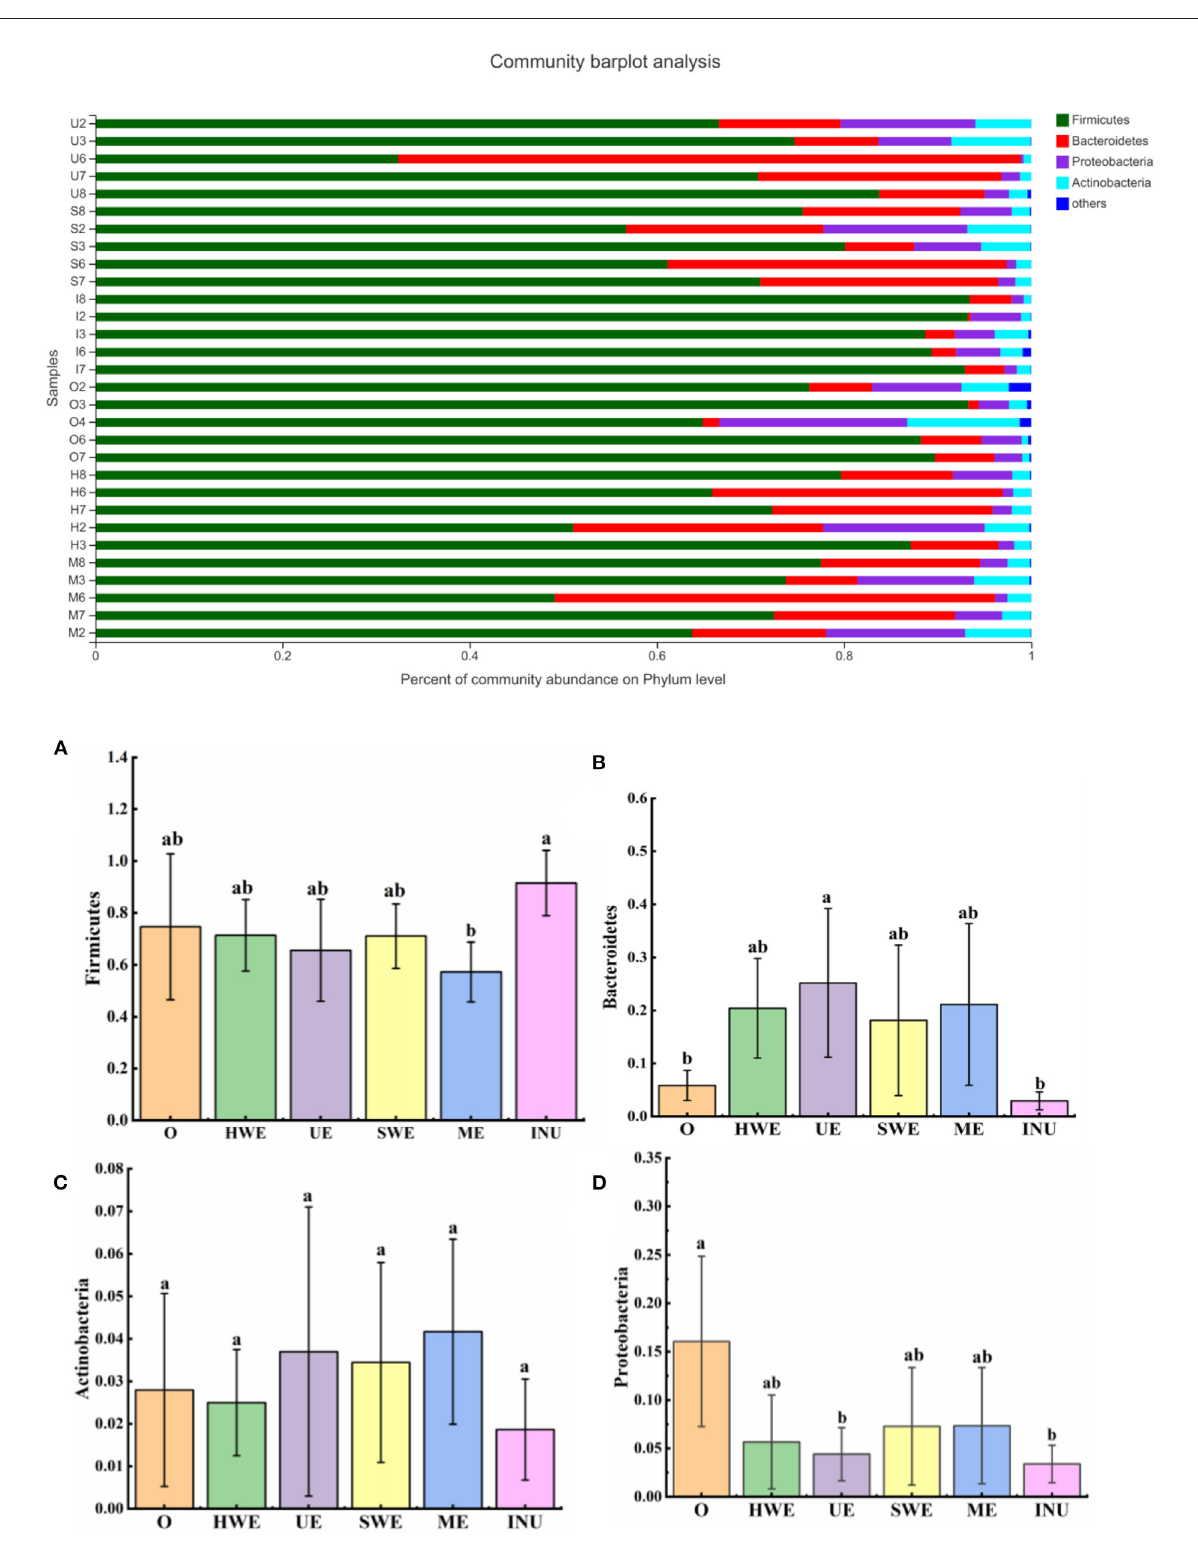
FIGURE7 (A-D) Relative abundance of gut microbiota at the phylum level ( n = 5). O stands for blank control group. HWE or H, UE or U, SWE or S, and ME or M stand for dietary fiber extracted with hot water, ultrasonic assisted, subcritical water, and microwave assisted methods, respectively. INU or I stand for inulin. Different letters a and b indicate significant differences ( p < 0.05), the same letters indicate that the differences are not significant ( p >